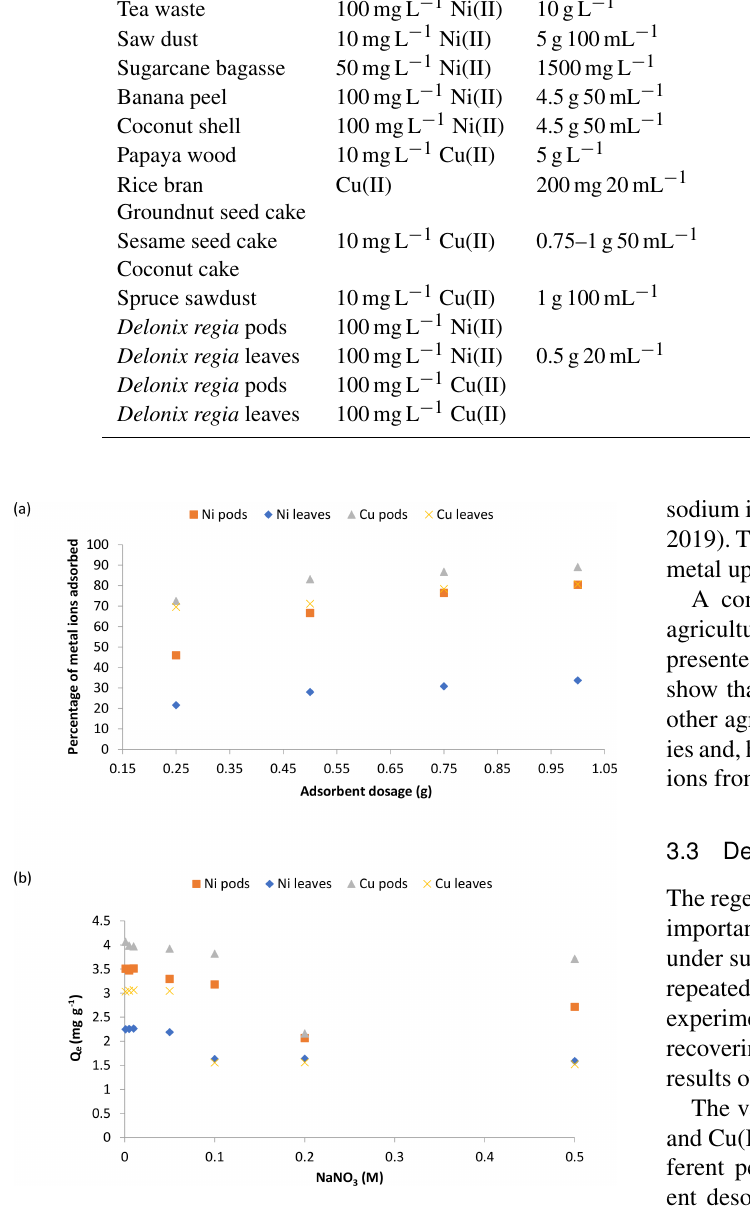
Figure 7. The effect of the adsorbent dosage (a) and the ionic strength (b) on the adsorption of Ni(II) and Cu(II) ions by Delonix regia pods and leaves. The experimental conditions were as follows: a pH 4 and 5, a contact time of 30min and a metal ion concentration of 100mgL − 1